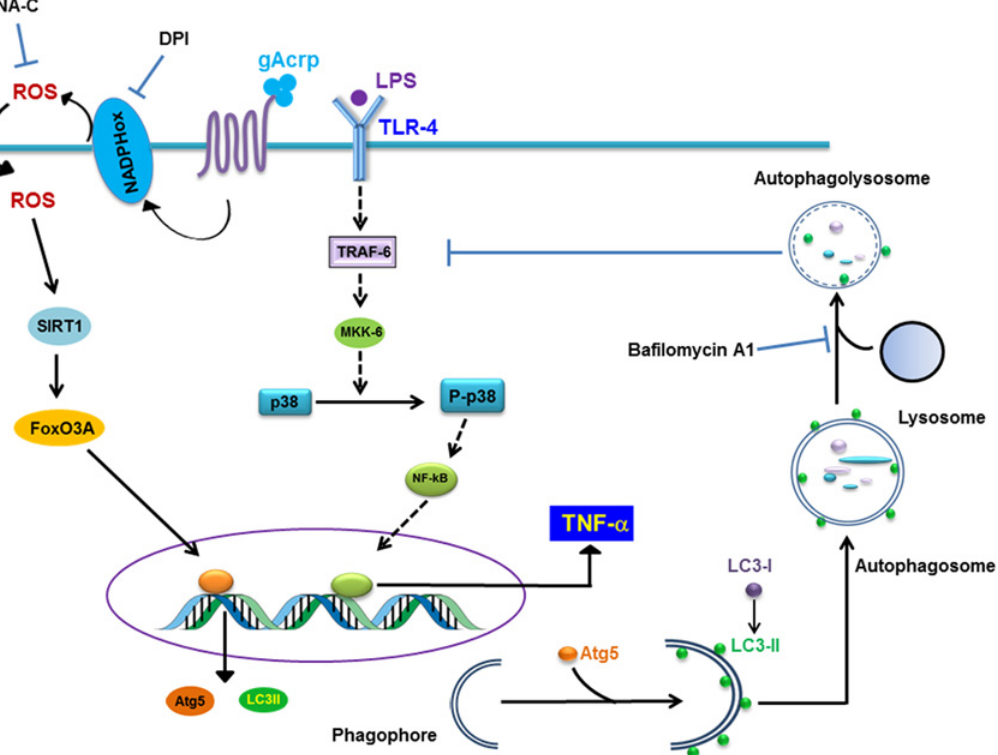
Fig 8. Proposed model of role of globular adiponectin-induced autophagy on suppression of LPS-induced TNF- α expression in RAW 264.7 macrophages. LPS treatment induces increase in TNF- α expression in macrophages via activation of TLR4 signaling, including TRAF6 induction, MKK-6 activation, p38MAPK phosphorylation and transcriptional activation of NF- κ B. Treatment of macrophages with globular adiponectin causes expression of genes related with autophagy, including LC3II and Atg5, through activation of FoxO3A signaling, which is dependent on ROS production and SIRT1 expression. The autophagosome formation by gAcrp causes sequestration and degradation of TRAF6, further dampens the LPS-activated TLR4 signaling by inhibition of phosphorylation of p38MAPK, leading to the inhibition of LPS-stimulated TNF- α expression. Detailed molecular mechanism explaining how autophagy degrades TRAF6 and inhibits p38MAPK phosphorylation remained to be